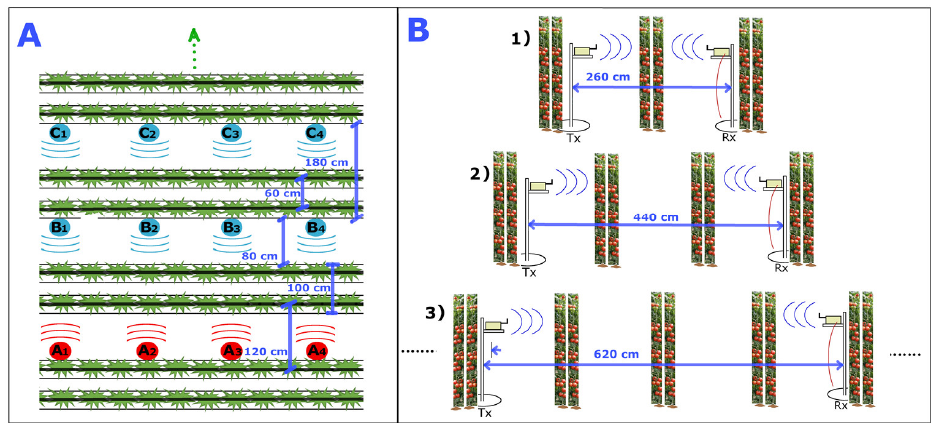
Figure 5. ( A ) The figure on the left shows a planting frame inside the greenhouse where the transmitting node (light blue) changes the distance with respect to the receiving node (red). ( B ) On right the figure shows that the height of both nodes was maintained constant while the distance between them changed.